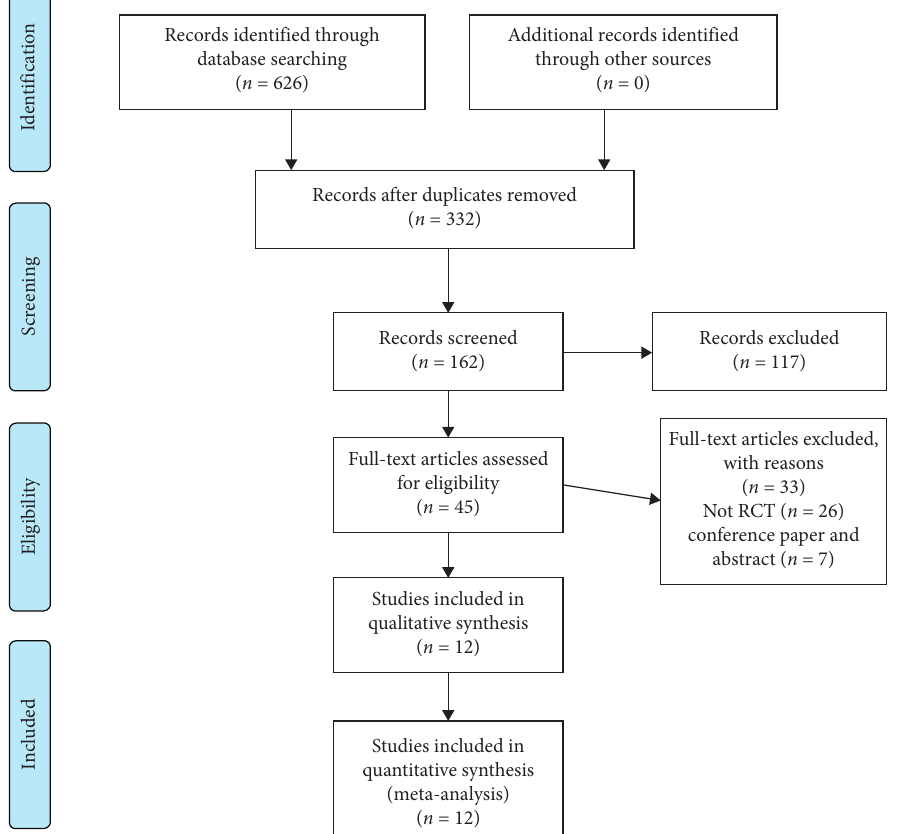
Figure 1: Study selection procedure according to the PRISMA